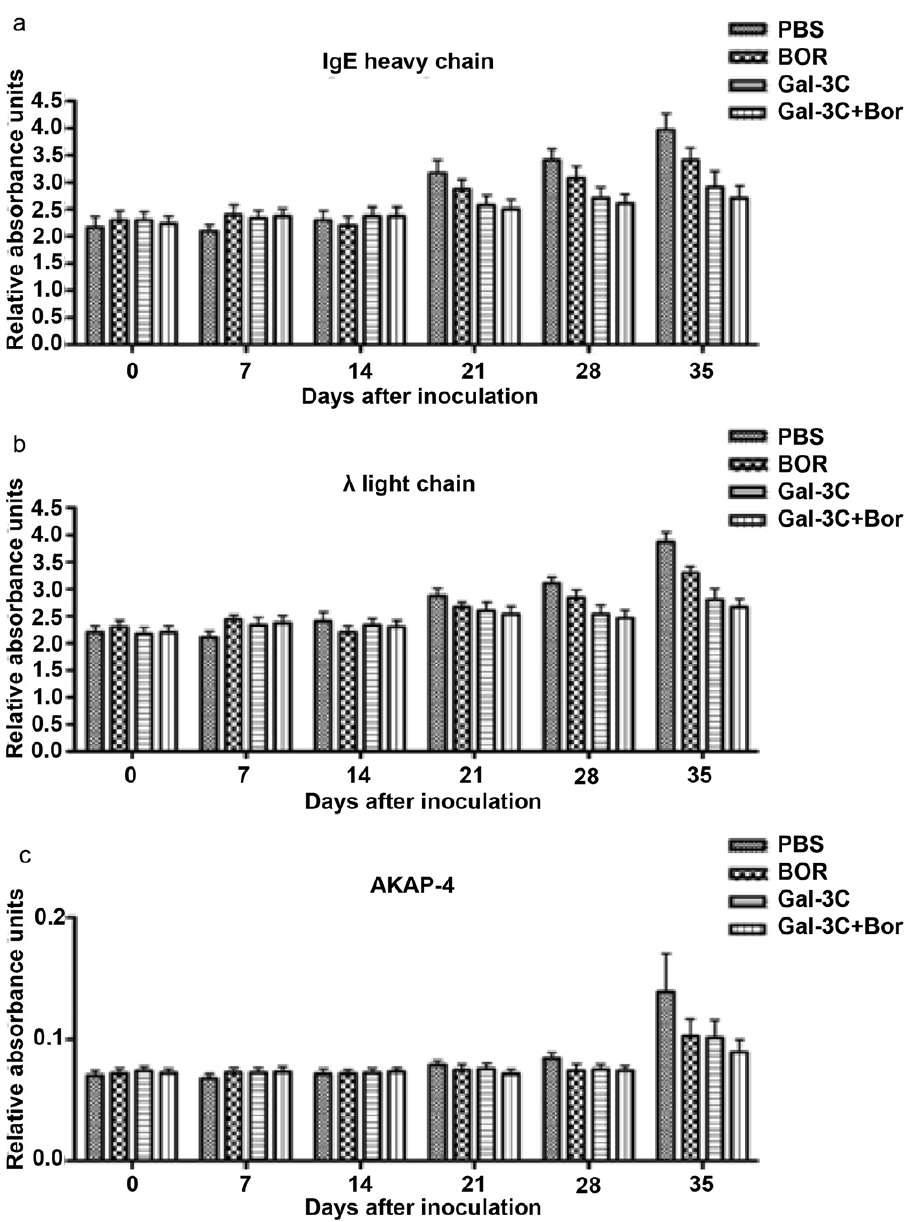
Figure 9. ELISA for human immunoglobulins and AKAP-4 in mouse sera. The mice were bled at the indicated time point after inoculation of U266 cells, and the levels of IgE heavy (A) and light chains (B), and AKAP-4 (C), were determined by ELISA. The levels of heavy and light chain IgE and AKAP-4 were significantly lower in the treated groups than in the PBS group ( P , 0.05) on d 21, 28, and 35, and the levels in the Gal-3C plus Bor animals were the lowest of any group. Each graph is representative of three experiments with samples analyzed in triplicates, and the error bars represent 6 SD.